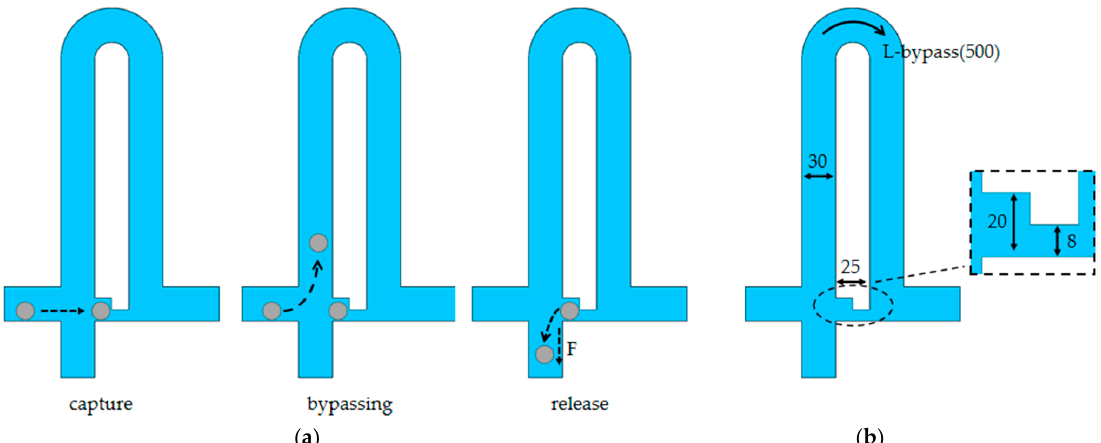
Figure 5. Mechanism of single-cell sorting. ( a ) A schematic diagram showing cell capture, bypassing, and release; ( b ) the speci fi c dimensions of the isolation structure.